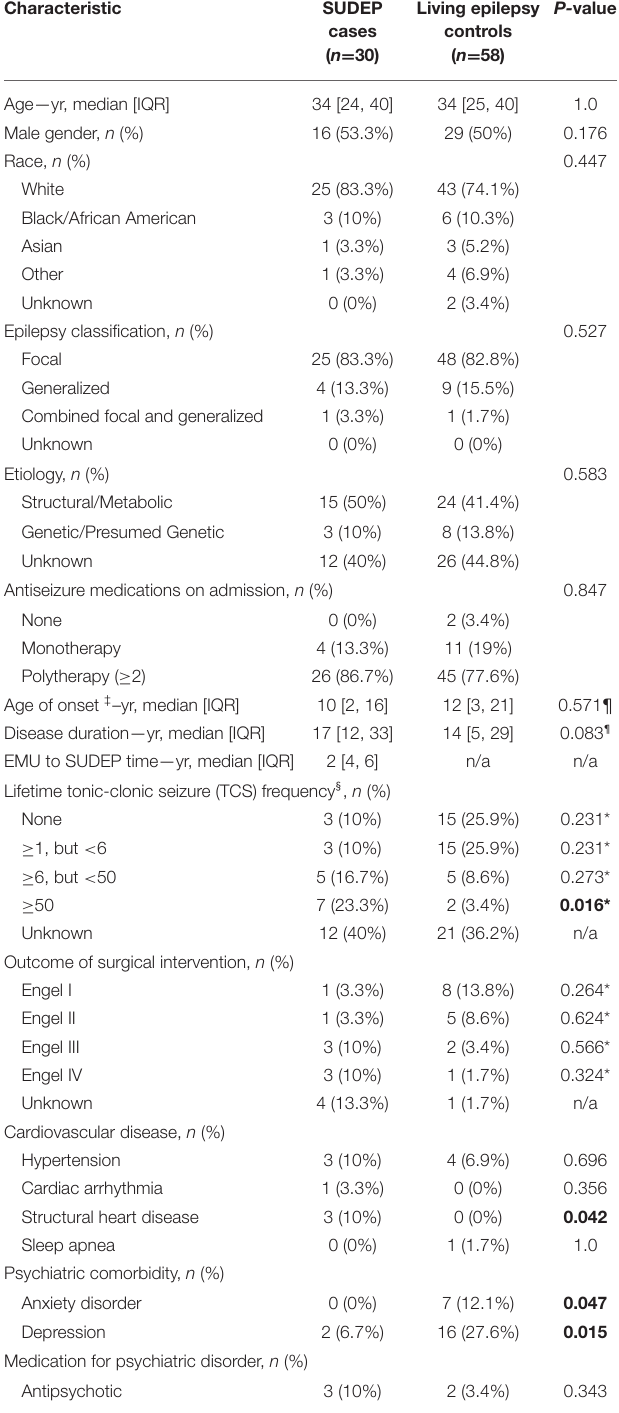
classification utility. From the combined features (i) and (ii), TABLE 1 | Demographical and clinical characteristics of the study population [modified from Ref. (25)]. we identified an optimal subset and compared cross-validated accuracy ( Supplementary Figure S4 ). The optimal set of EEG Characteristic SUDEP + ECG features varied between 2 and 5 and we reported the cases statistics using 3. We trained classifiers using single or combined features separately. For the L 1 regularized LR classifier using features (i) + (ii), the significant coefficients include alpha